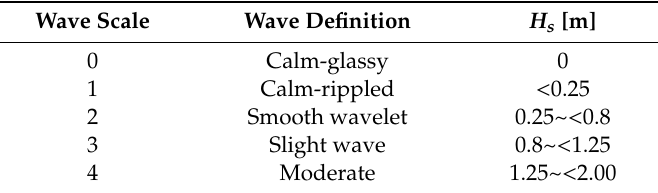
Table 1. Classification of sea states.